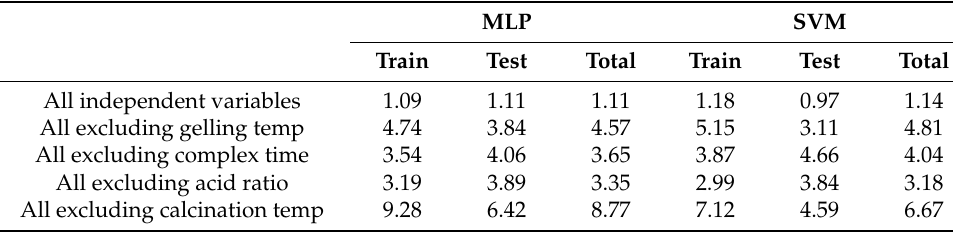
Table 2. Sensitivity analysis of MLP and SVM models based on RMSE